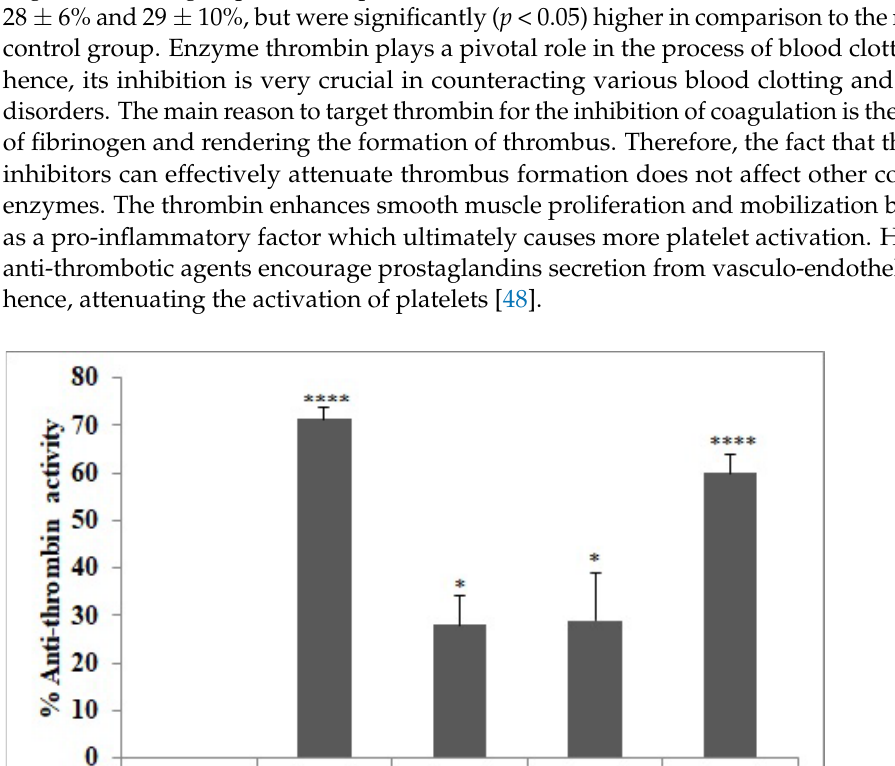
Figure 5. Effect of various treatments on tail bleeding time in experimental animals. Results are expressed as Mean ± SEM, ( n = 6), analysed by one-way ANOVA followed by Dunnett’s test of multiple comparison where ns = non-significant, **** p < 0.0001, * p < 0.05 where various treatment groups were compared with control group.